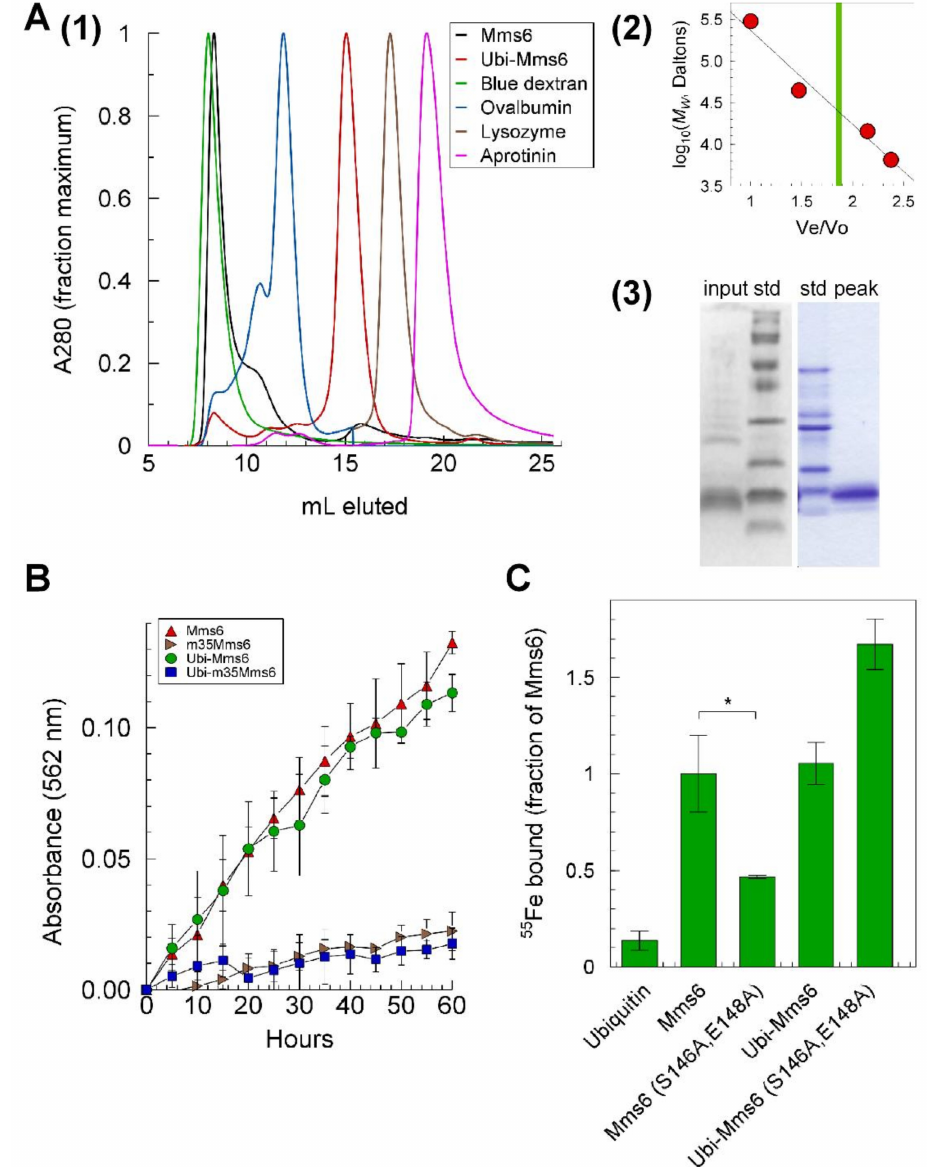
Figure 7. Monomeric Mms6 is a functional reductase but with altered C-terminal domain specificity for Fe 3+ : ( A ) ( 1 ) eluted peaks of standards, Mms6 and Ubi-Mms6; ( 2 ) standard curve derived from ( 1 ) with a vertical green line showing the elution position of Ubi-Mms6, M W : molecular weight, Ve/Vo = elution volume/void volume; ( 3 ) gel electrophoretic profile of Ubi-Mms6 prior to loading and in the peak eluted at ~15 mL std: molecular weight standard proteins; input: Ubi-Mms6 sample loaded on the column, peak, sample from the Ubi-Mms6 peak as identified in the A280 profile (A1); ( B ) time courses of reductase activity in the presence of 350 µ M ferric citrate in 20 mM Tris, 100 mM KCl, pH 7.5 with 100 uM each of NADH and FAD with 0.8 mM ferrozine. For each binding isotherm, the data from three independently performed experiments, each normalized to a midpoint value, were averaged, and similarly treated data in the presence of each protein but no ferric citrate was subtracted. The error bars are the square root of the sum of the squares of the errors with and without ferric citrate; ( C ) the amount of iron bound per µ mole of protein in 20 µ M 55 Ferric citrate was determined as described in Materials and Methods and expressed as a proportion of the amount bound by Mms6. The asterisks denote a p value of <0.05 (*) in a paired comparison with